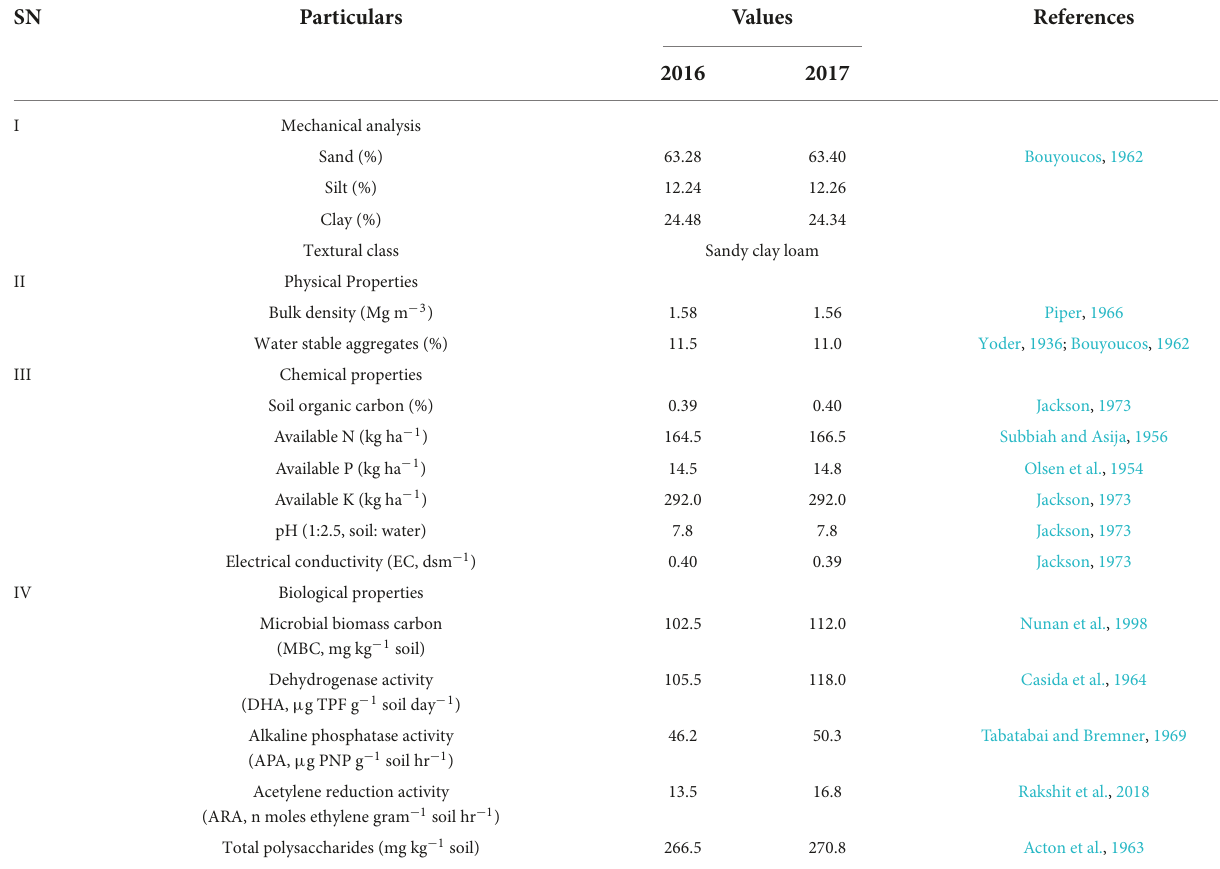
TABLE 1 Physico-chemical and biological properties of the experimental field (initial value).